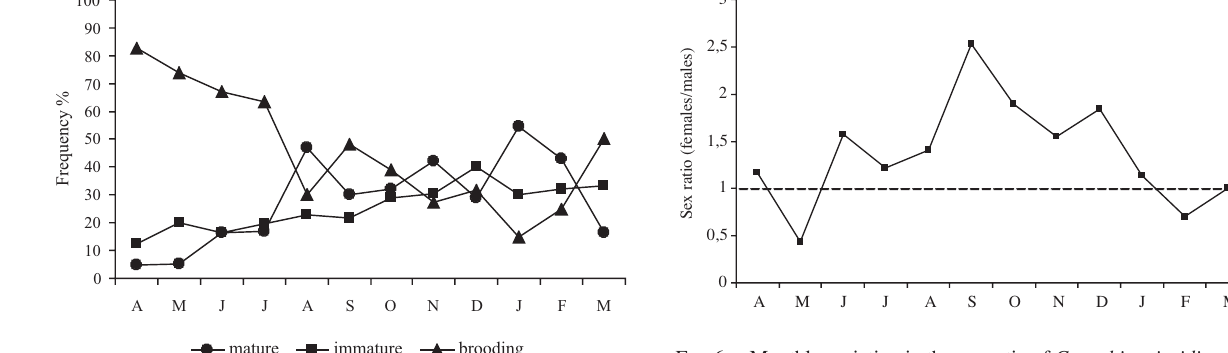
F IG . 6. – Monthly variation in the sex ratio of Corophium insidiosum . F IG . 4. – Monthly variation of the frequency of mature, immature and brooding females